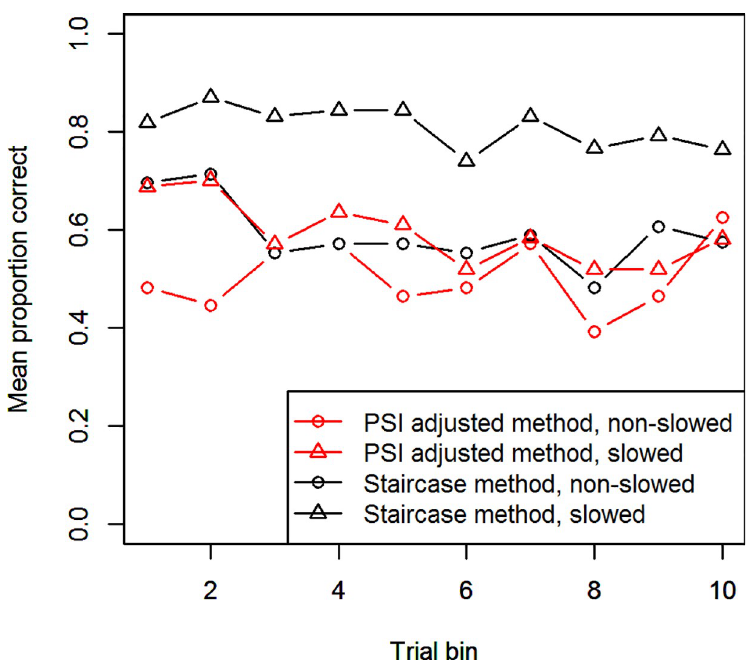
Fig 12. Accuracy throughout Experiment 2. As Fig 3, the proportion of successful Change-trials for the PSI adjusted and Staircase methods, separately for slowed and non-slowed participants.